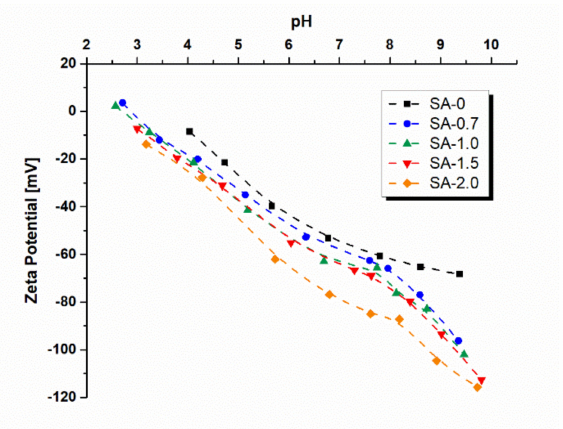
Figure 7. Dependence of zeta potential of the selective layer surface on pH of the reference PSF/Synperonic F108 (SA-0) and modified PSF/Synperonic F108/PAA (SA-0.7, SA-1.0, SA-1.5, and SA-2.0)